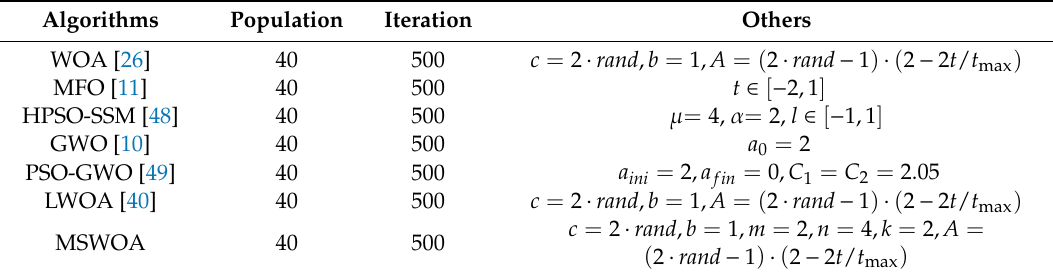
Table 2. Parameters settings of examined